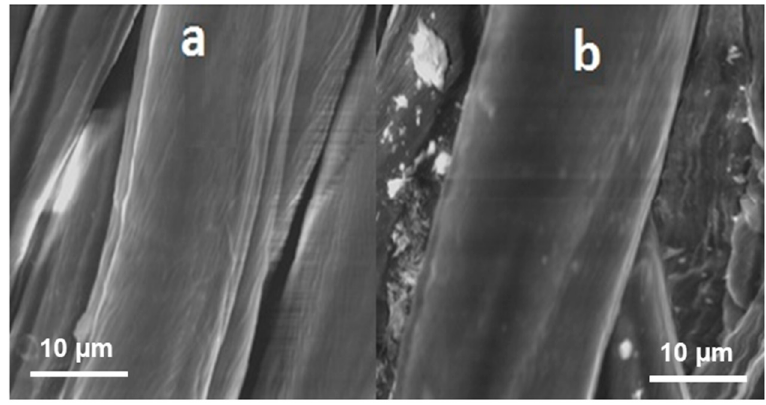
Figure 10. SEM images of ( a ) untreated sample (US) and ( b ) optimized condition (OC) sample.